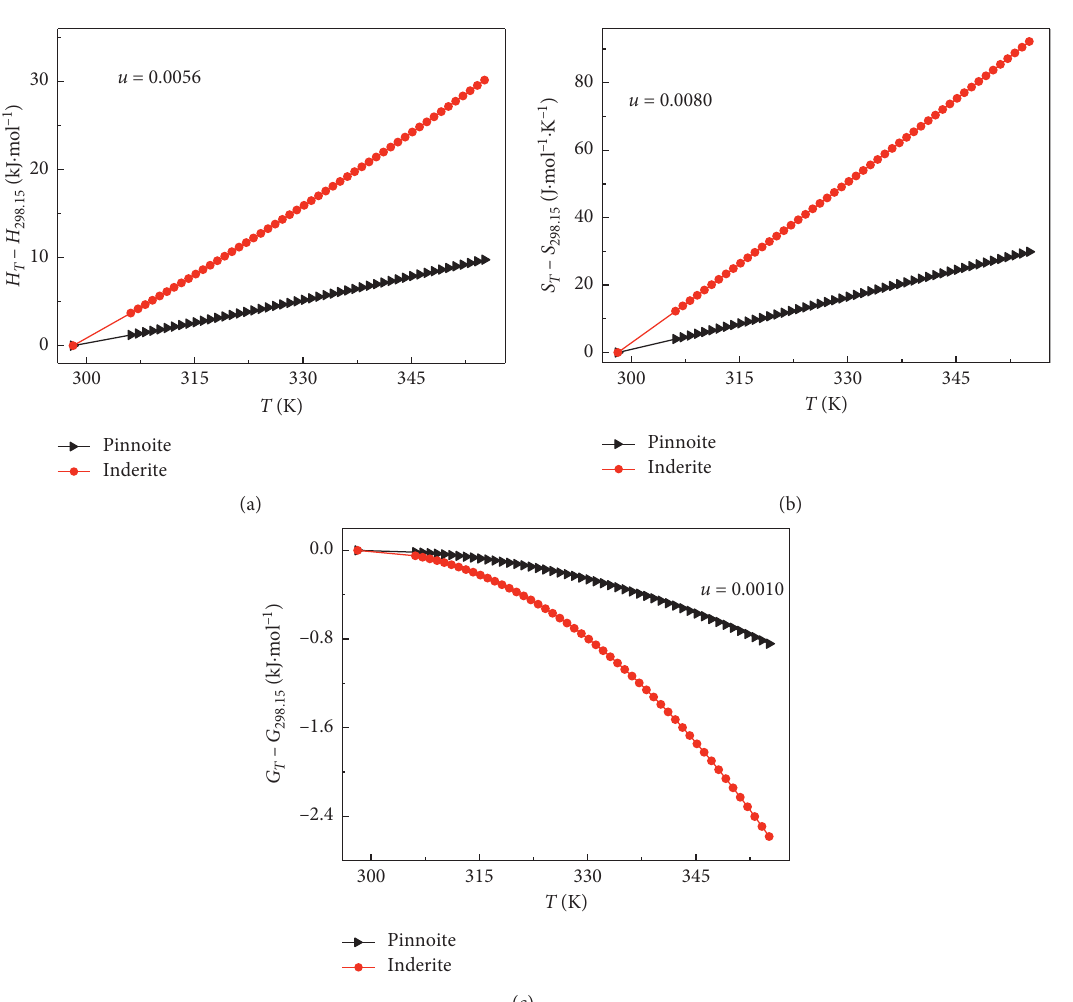
− G 298.15 ) with T for pinnoite and